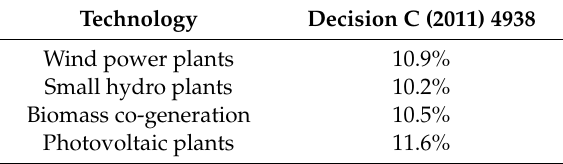
Table 2. Internal rate of return for technologies promoted by the support